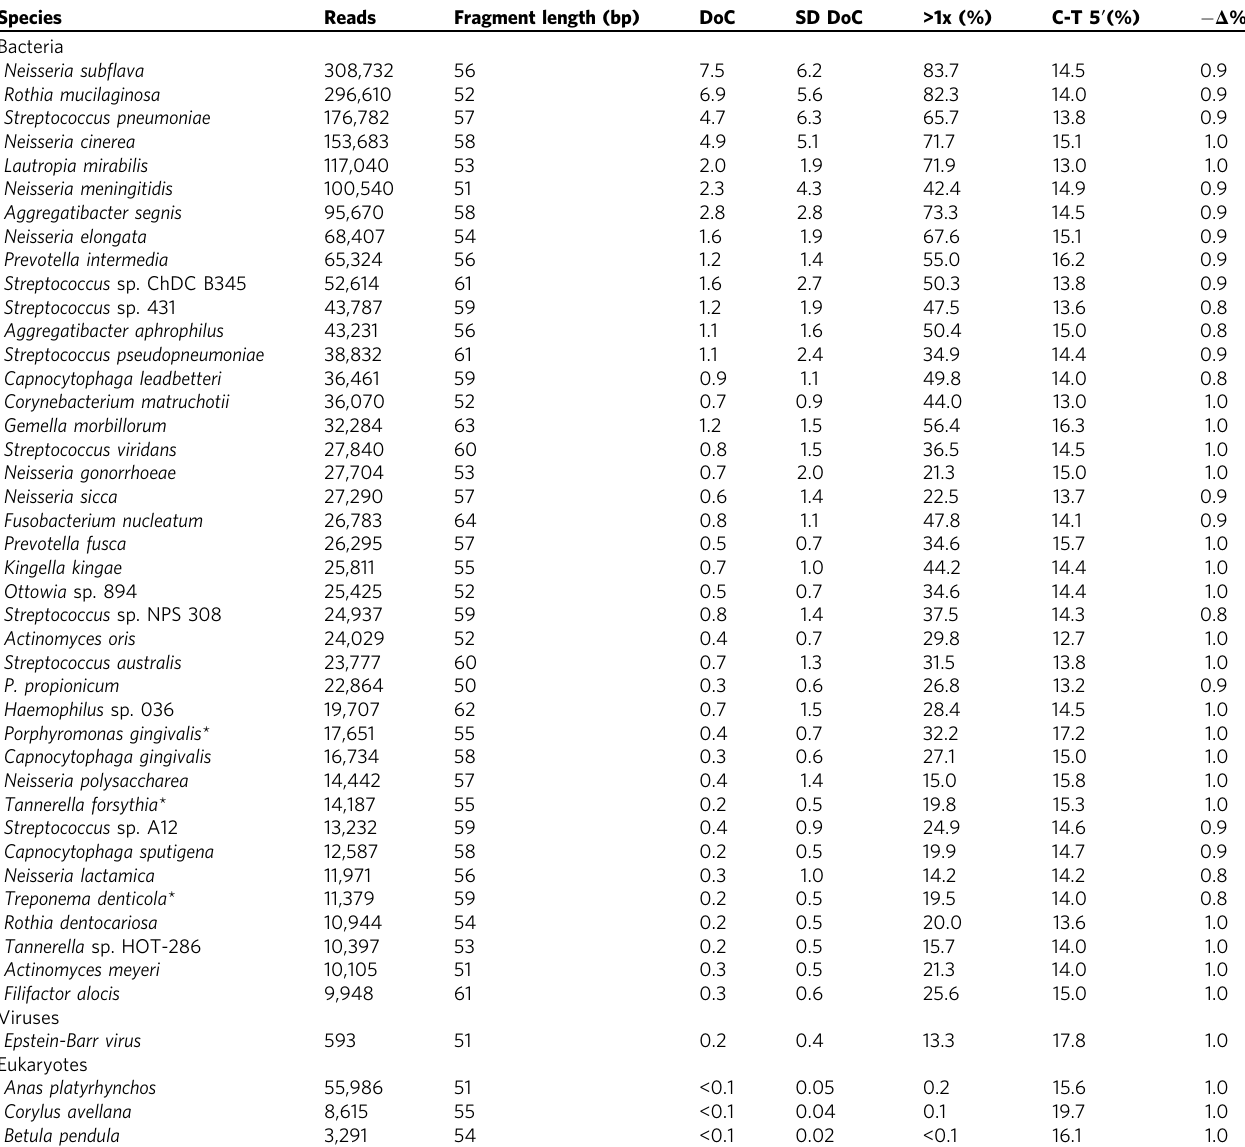
Table 1 List of non-human taxa identi fi ed in the Syltholm pitch, including the 40 most abundant oral bacterial taxa, viruses, and eukaryotes. Bacteria in the red complex are denoted with an asterisk. Depth (DoC) and breadth of coverage (>1x) were calculated using BEDTools 72 . Deamination rates at the 5 ’ ends of DNA fragments were estimated using mapDamage 2.0.9 59 . - Δ % refers to the negative difference proportion introduced by Hübler et al 79 . (see Supplementary Note 5).